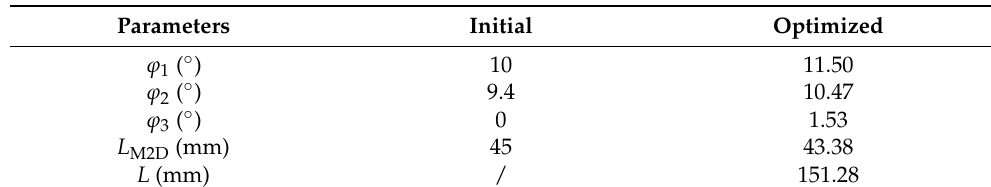
Table 3. Initial and optimized parameters of the optical system.